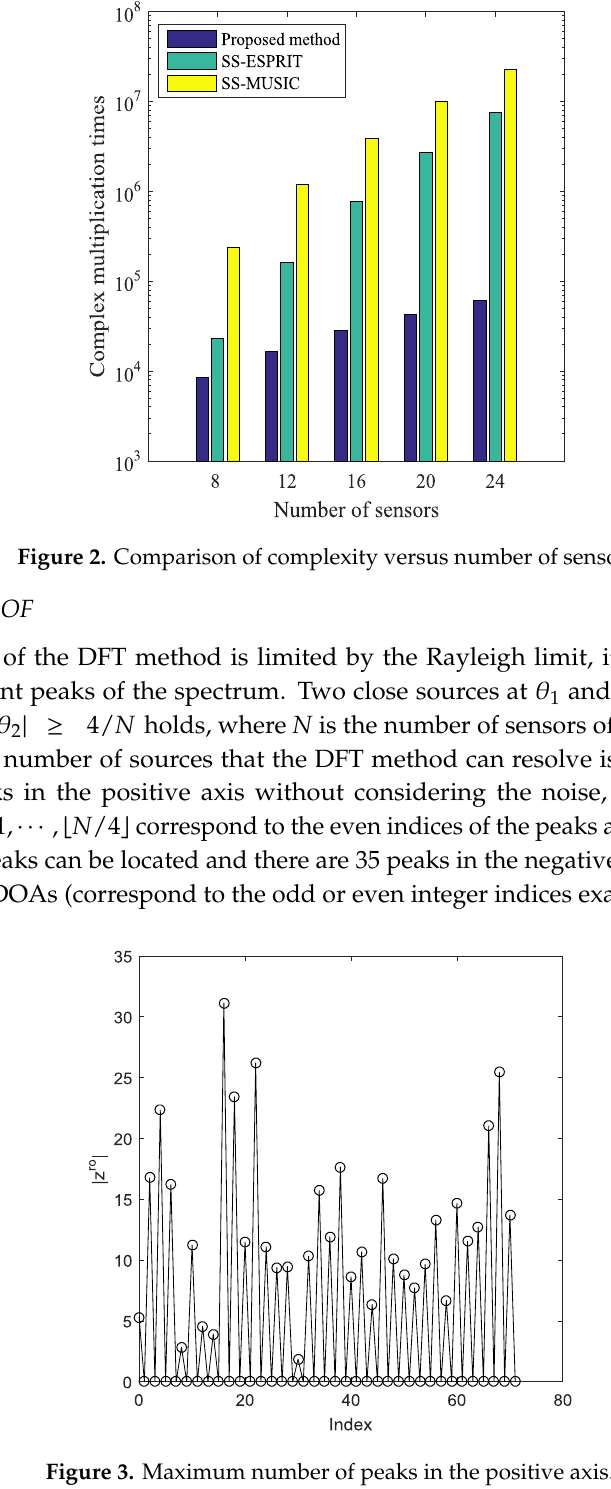
Figure 3. Maximum number of peaks in the positive axis.